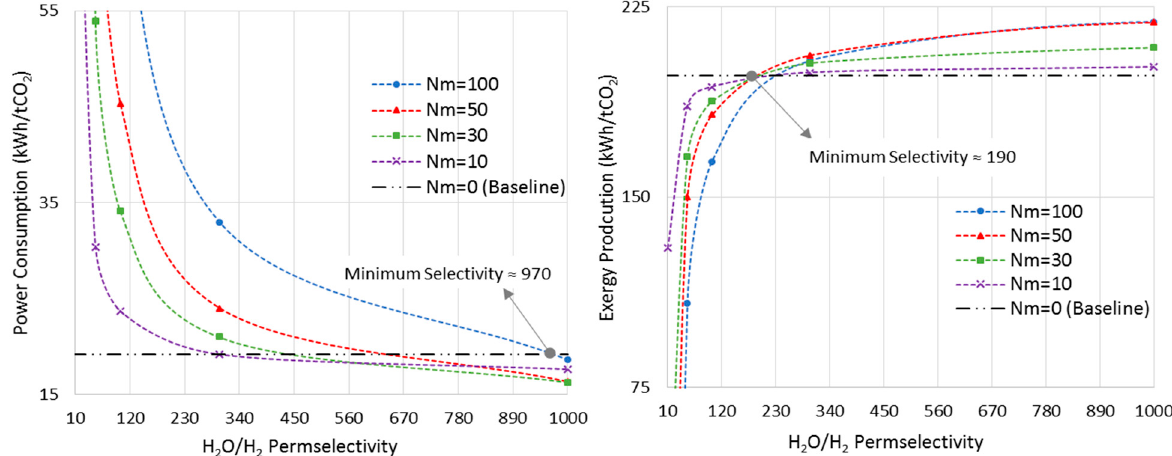
Figure 10. Power consumption/exergy production for isothermal-MR-based process at 7500 kPa with different Nm versus H 2 O/H 2 permselectivity.